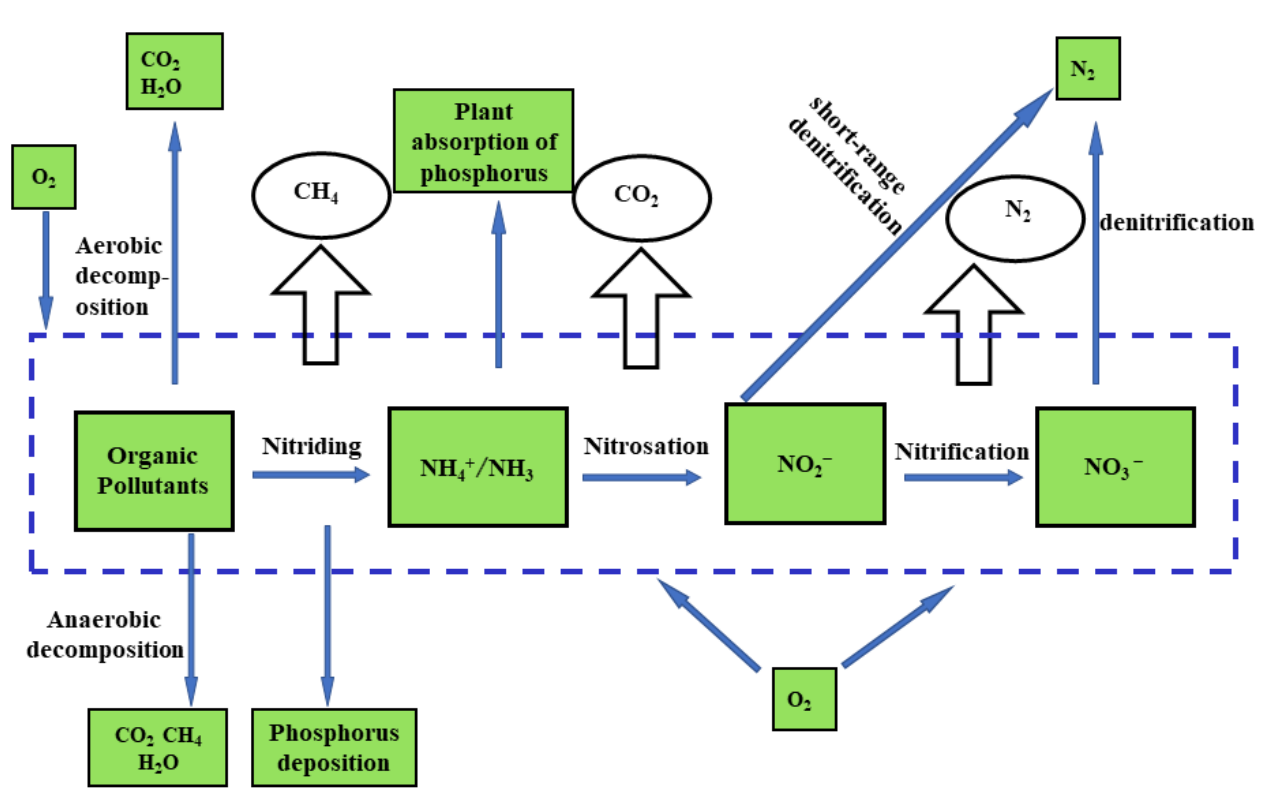
Figure 4. A schematic showing the general steps of biological denitrification in wastewater treatment. Table 2. Comparison of various indicators among various denitrification and conventional treat- ment processes.